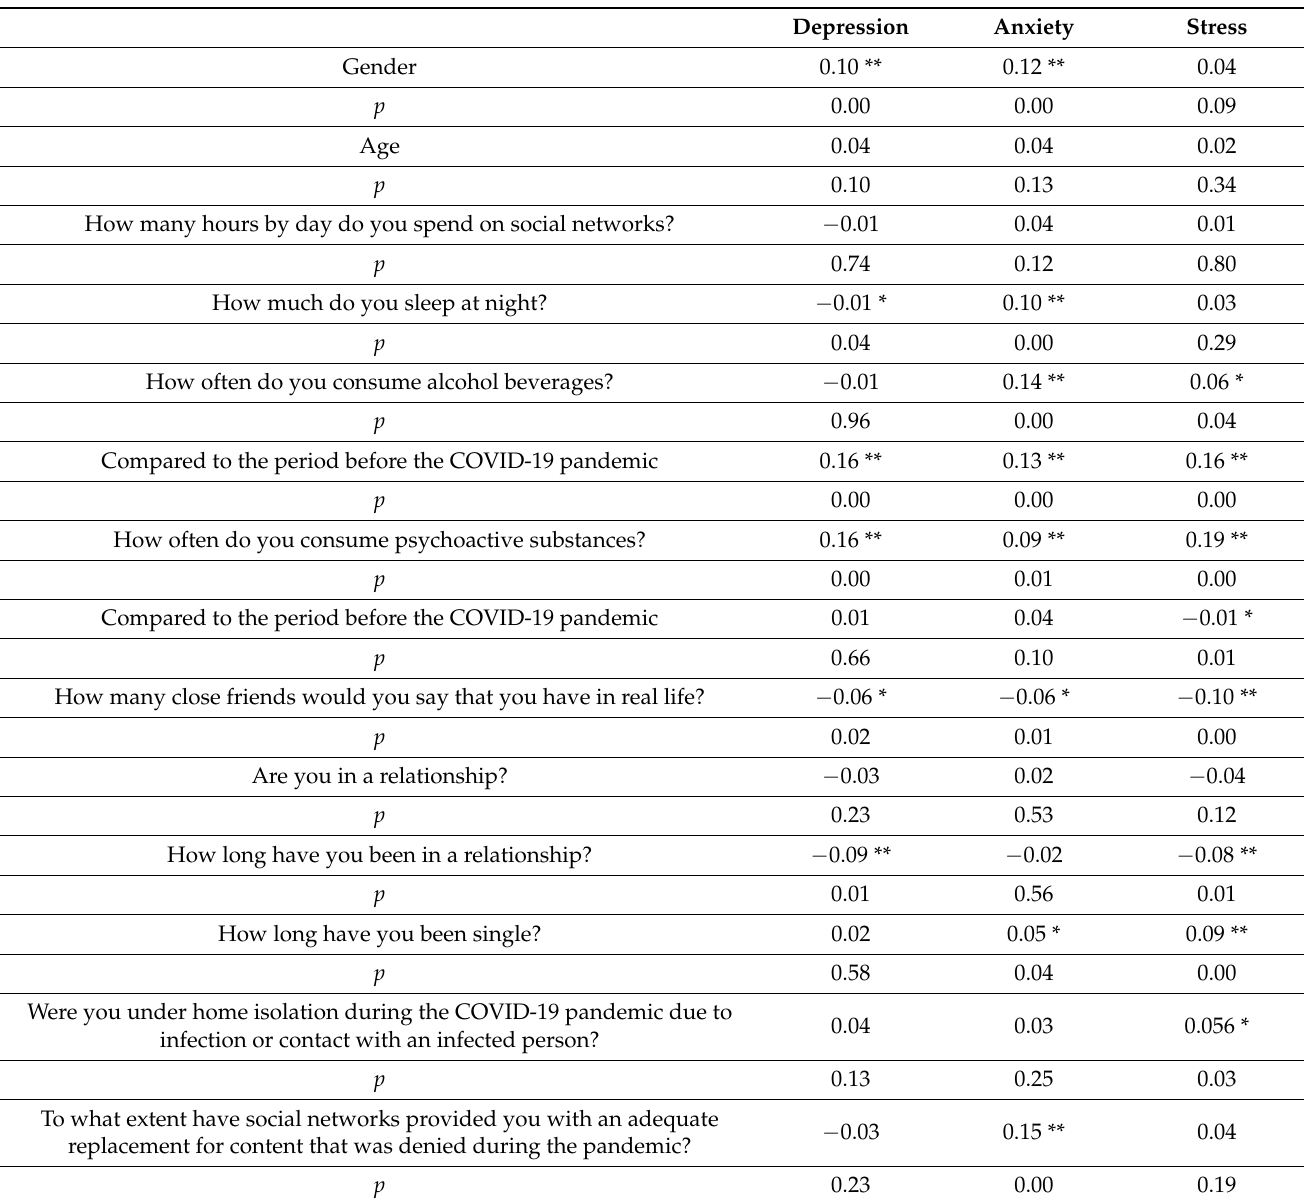
Depression Anxiety Stress